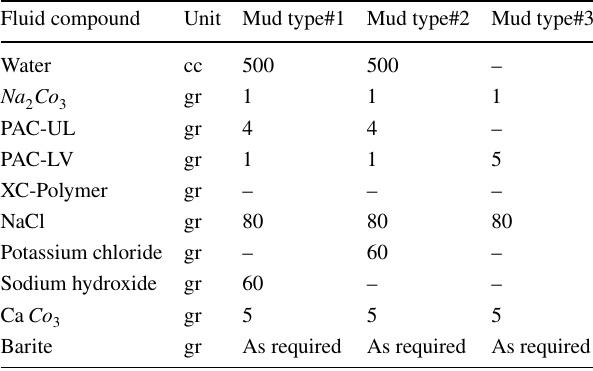
Table 2 Formate fluid composition Fluid compound